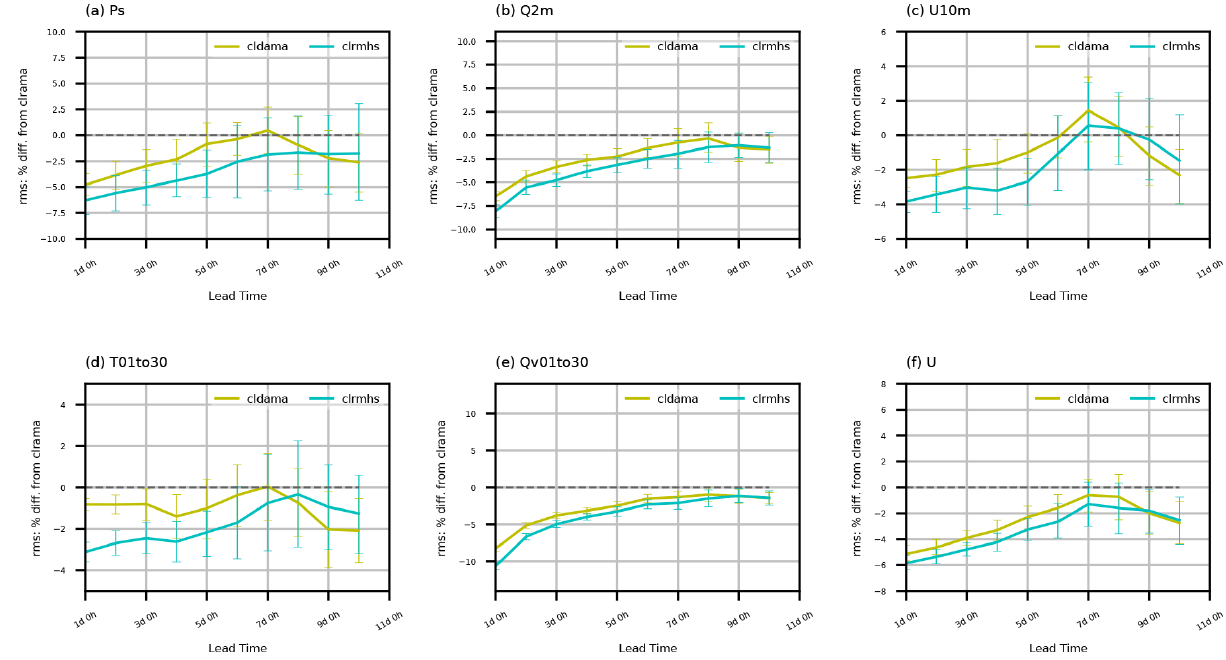
Figure 8. Relative RMSE reductions (with respect to GFS analyses) as a function of forecast lead time for global (a) surface pressure, (b) specific humidity at 2m, (c) zonal wind at 10m, (d) temperature and (e) water vapor mixing ratio below model level 30, and (f) the whole-column zonal wind ( cldama and clrmhs versus clrama ). Statistics are aggregated over all 27 forecasts.